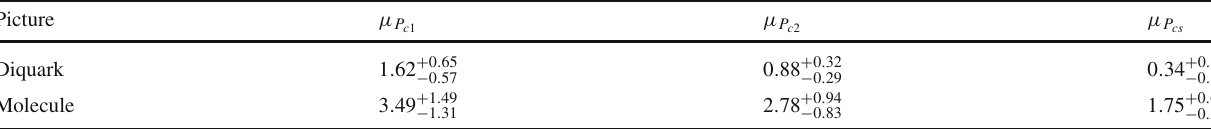
Table 1 Results of the magnetic dipole moments (in units of μ N ) for the pentaquark states